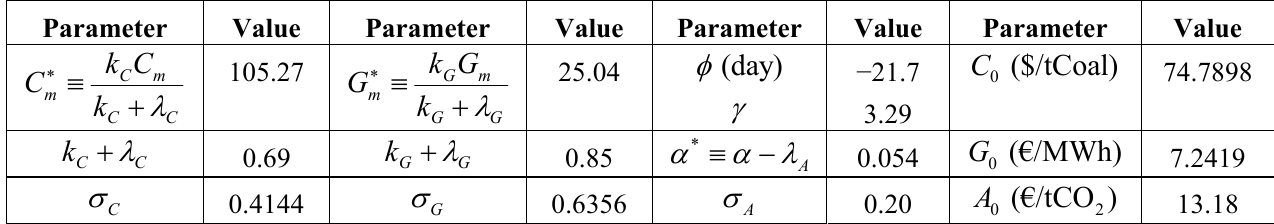
Table 3. Parameter estimates of commodity